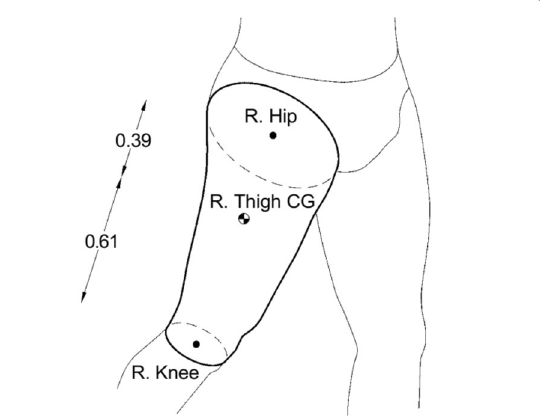
Figure 8 Location of center of gravity corresponding to adjacent